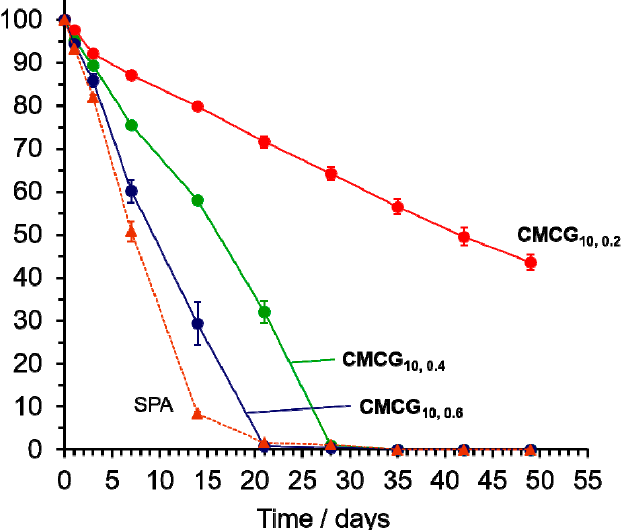
Figure 10. Time-dependence of the water-holding capacities of the CMCGs and SPA at a temperature of 298 K and a humidity of 55%.